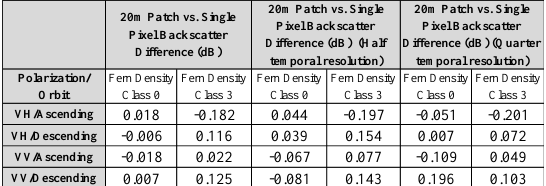
Table 3: Comparison of multi-pixel and single-pixel backscatter analysis and simultaneous reduction of temporal resolution to determine spatial and temporal stability, calculated for each single measurement location and then averaged over all